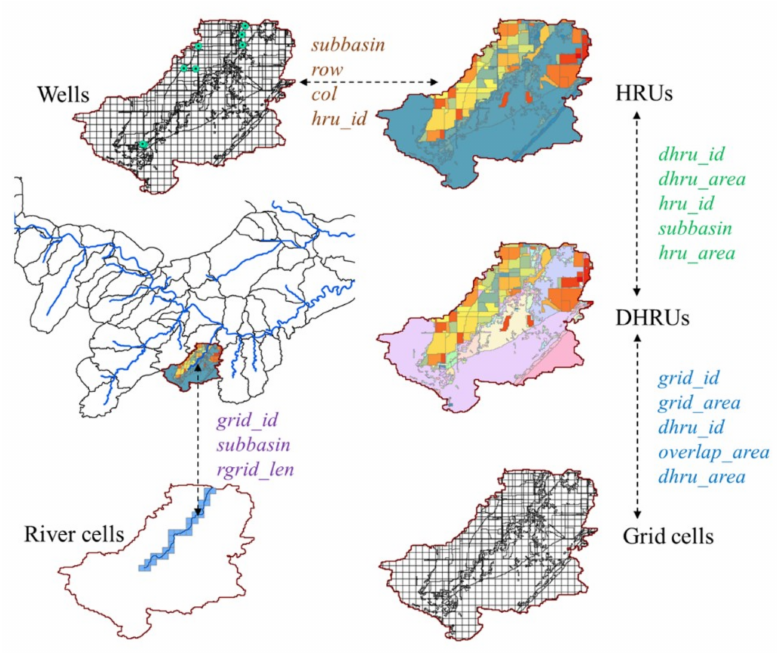
Figure 4. Information necessary to convert model output from hydrologic response units (HRUs) to geographically-located disaggregated HRUs (DHRUs), from DHRUs to MODFLOW grid cells, from SWAT sub-basin rivers to MODFLOW river cells, and from MODFLOW pumping wells to SWAT